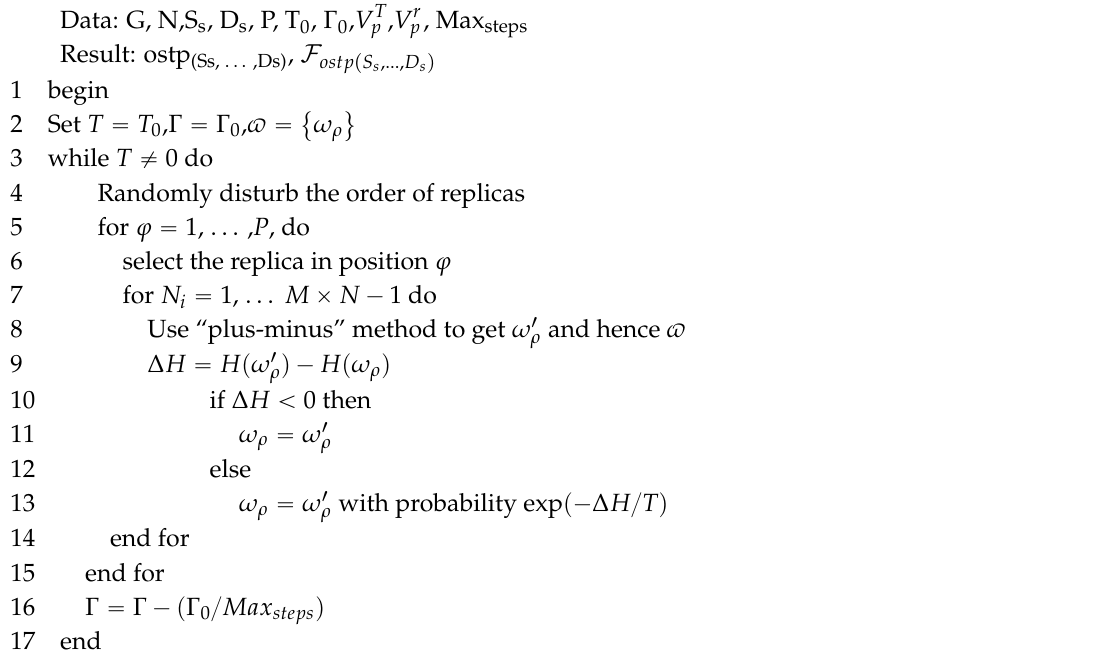
Algorithm 1. Pseudo-code of QA_OSTP for